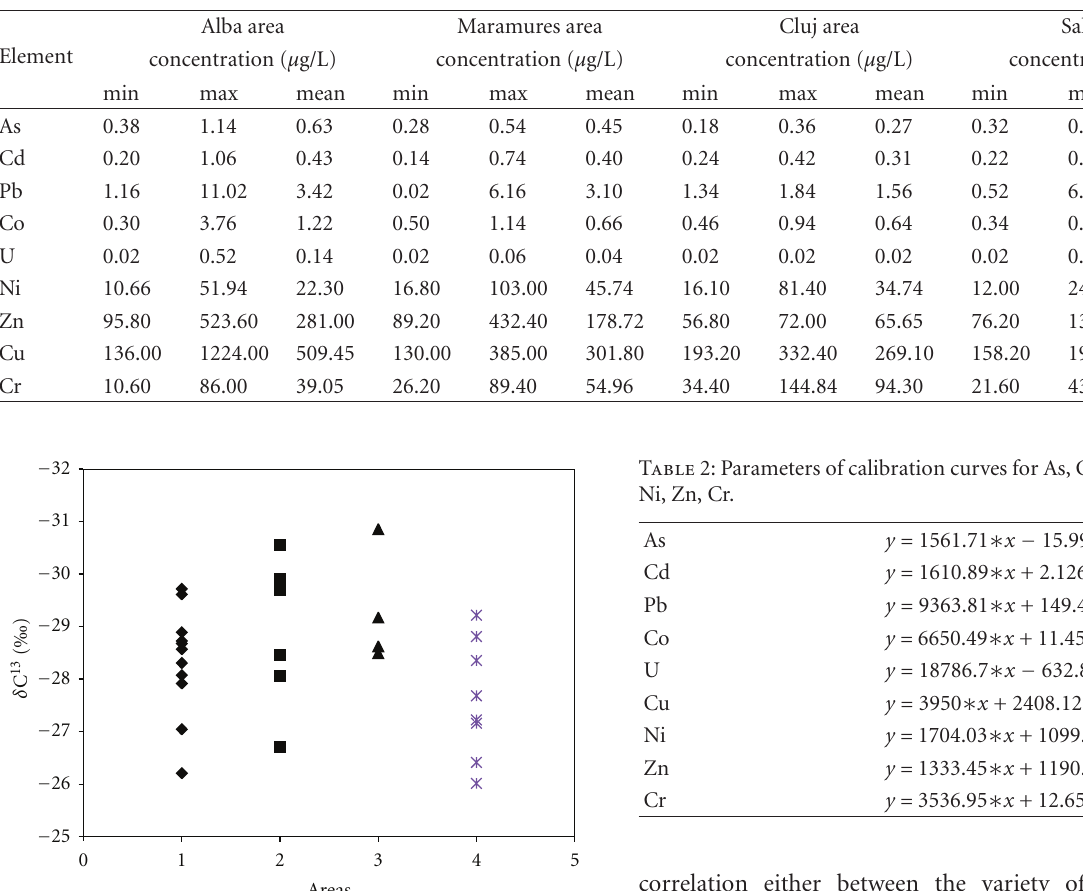
Table 1: Trace elements in apple juices from Transylvania.